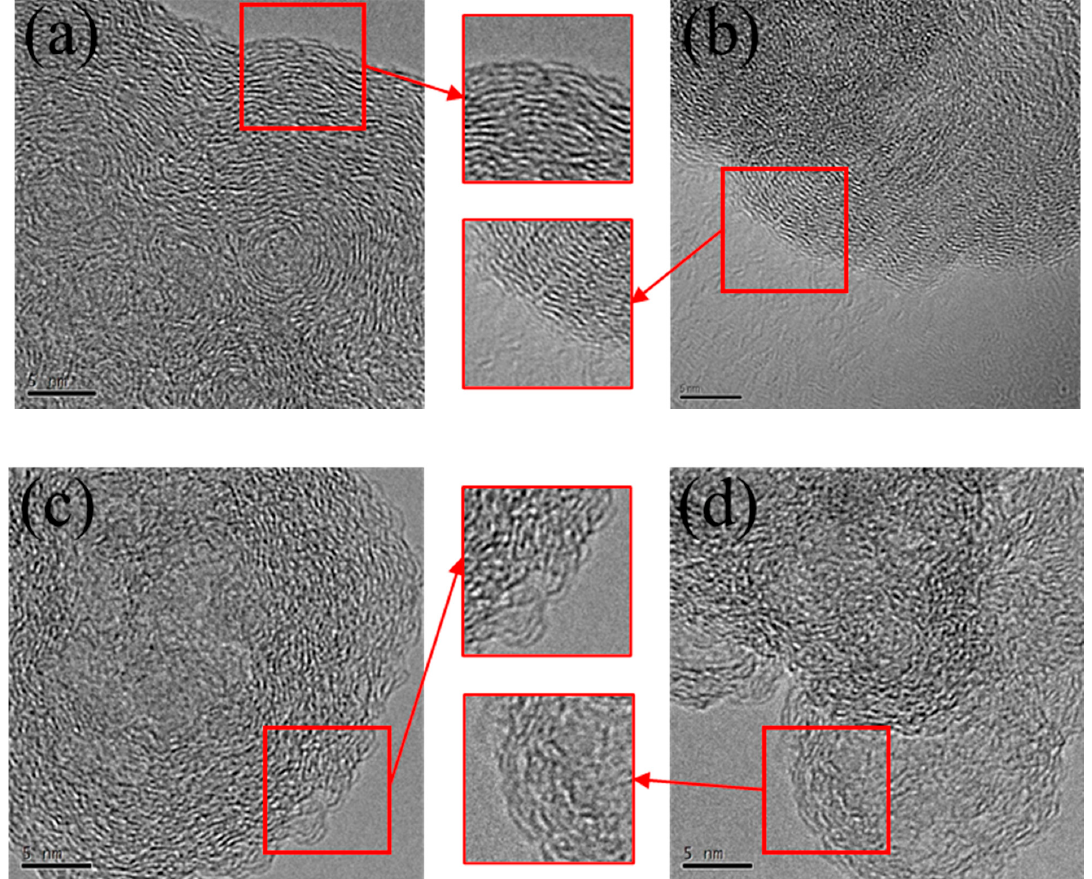
Figure 2. Microstructure comparison of soot particles with different oxidation rates of ( a ) 0%, ( b ) 56.1%, ( c ) 71.2%, and ( d ) 89.4% at 5 nm scale.